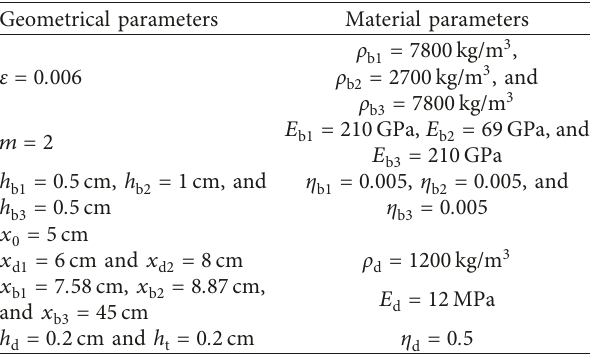
Figure 2: MHW values under different scaling and translation parameters. Table 1: Geometrical and material parameters of the sandwich ABH beam.